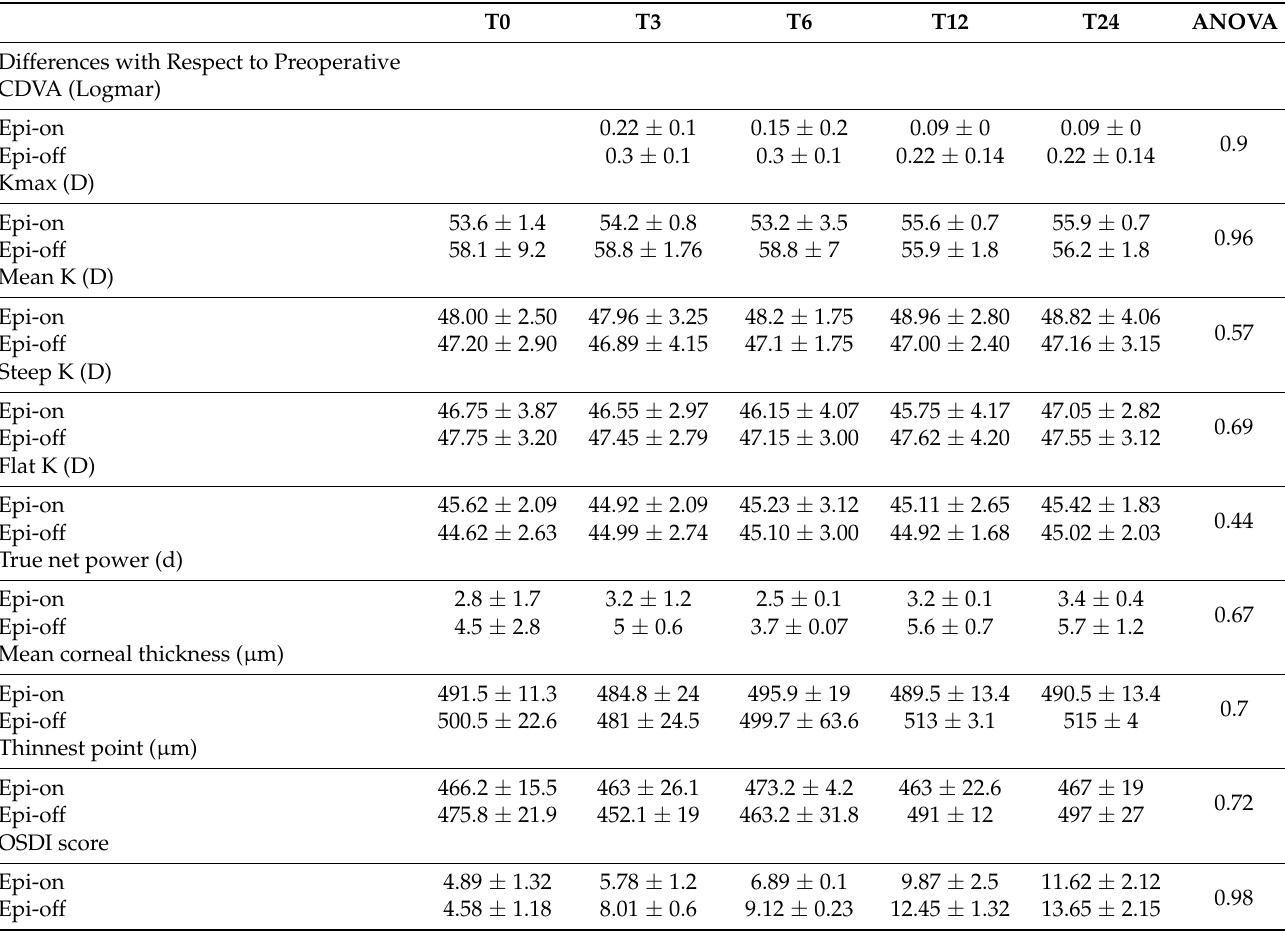
Table 2. Postoperative